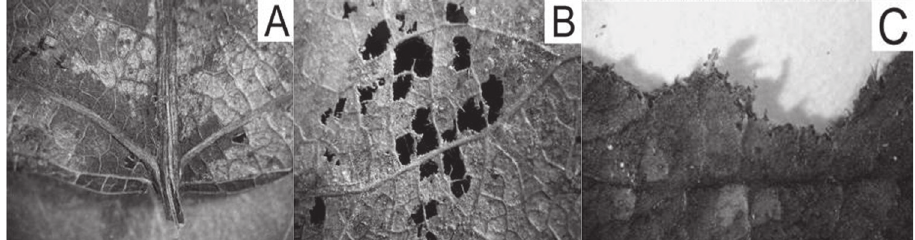
Figure 1. Patterns of litter degradation by Porcellio scaber size classes on poplar litter. A=small (0.2-0.5 mm in length), B=medium (0.7 – 10 mm), C=large (10 – 15 mm)